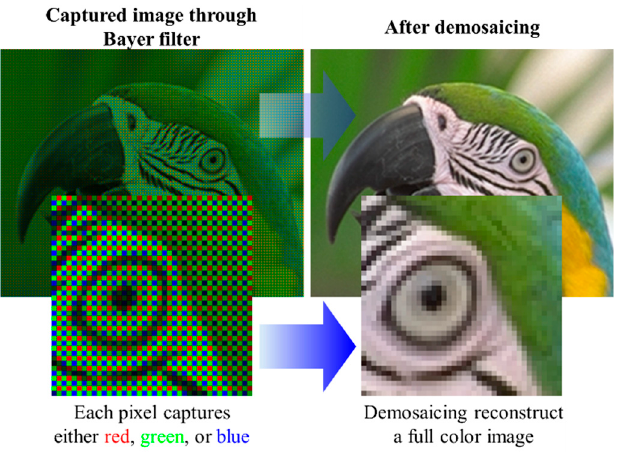
Figure 7. An example of the demosaicing process.